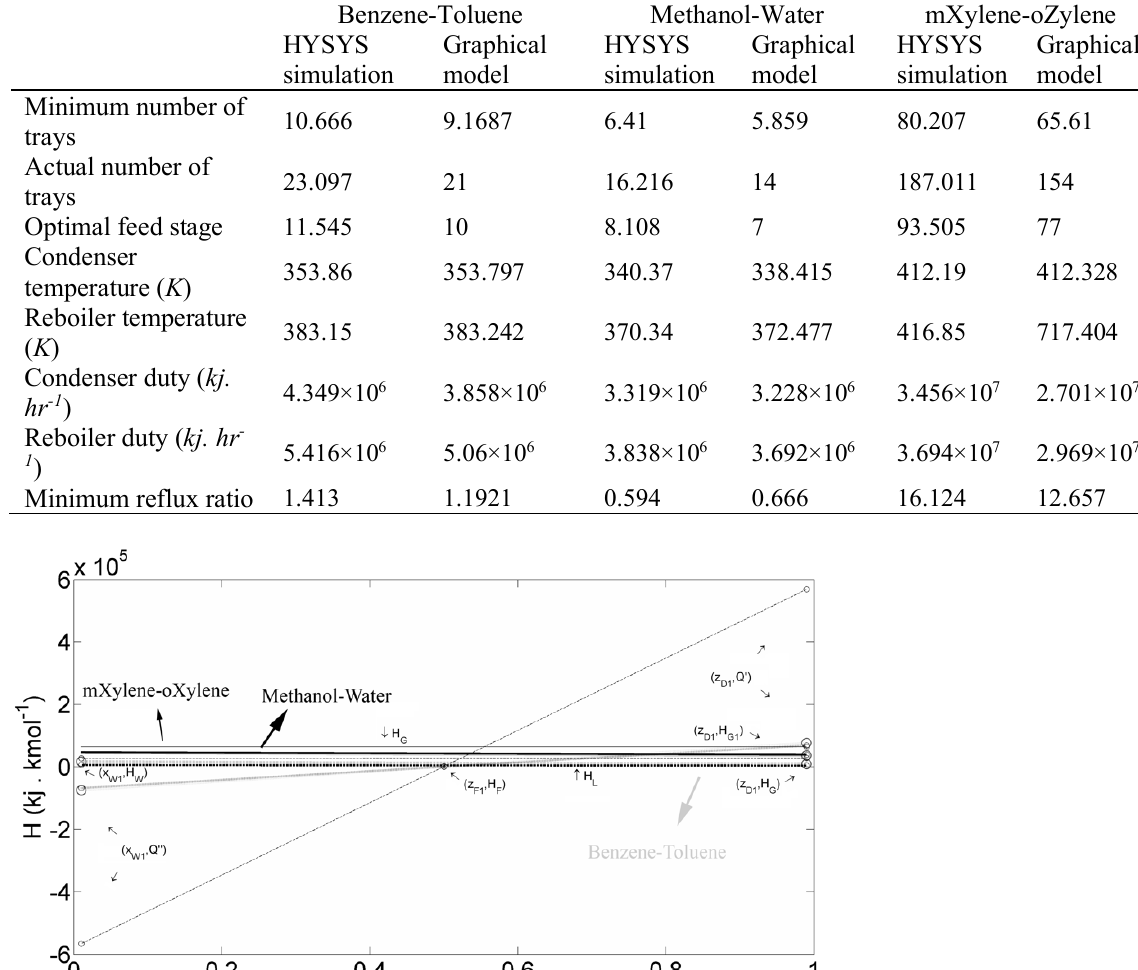
Table 2. Compression the results of graphical model (programmed by MATLAB) and HYSYS simulation.